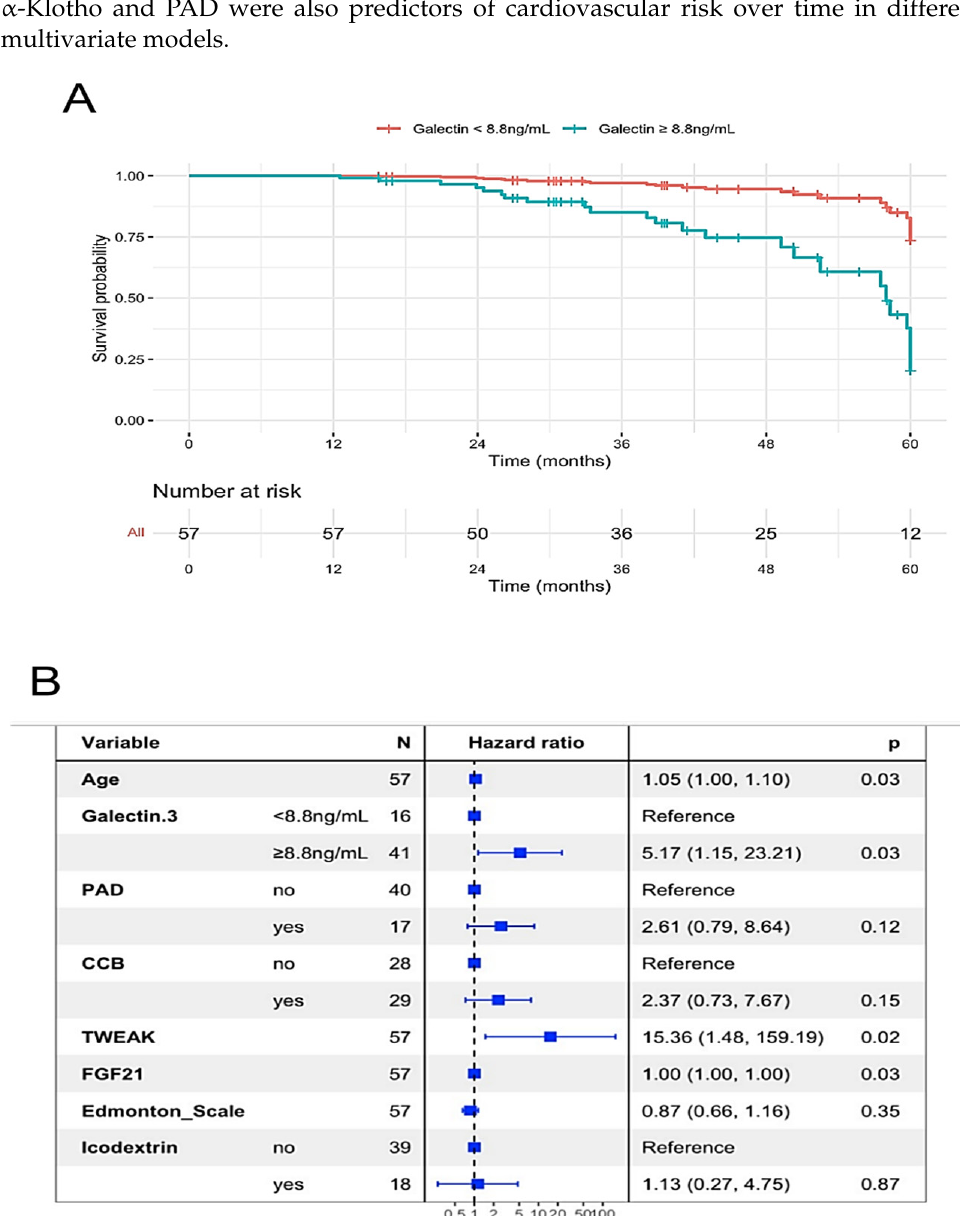
Figure 1. Predictors of time until failure in peritoneal dialysis (PD). ( A ) Survival curve of the peritoneal membrane according to galectin-3 cutoff of 8.8 ng/mL. ( B ) Multivariate Cox regression model of peritoneal dialysis failure using galectin-3 cutoff of 8.8 ng/mL. PAD—peripheral arterial disease; CCB—calcium channel blocker; TWEAK—Tumor necrosis factor-like weak inducer of apoptosis; FGF21—Fibroblast growth factor